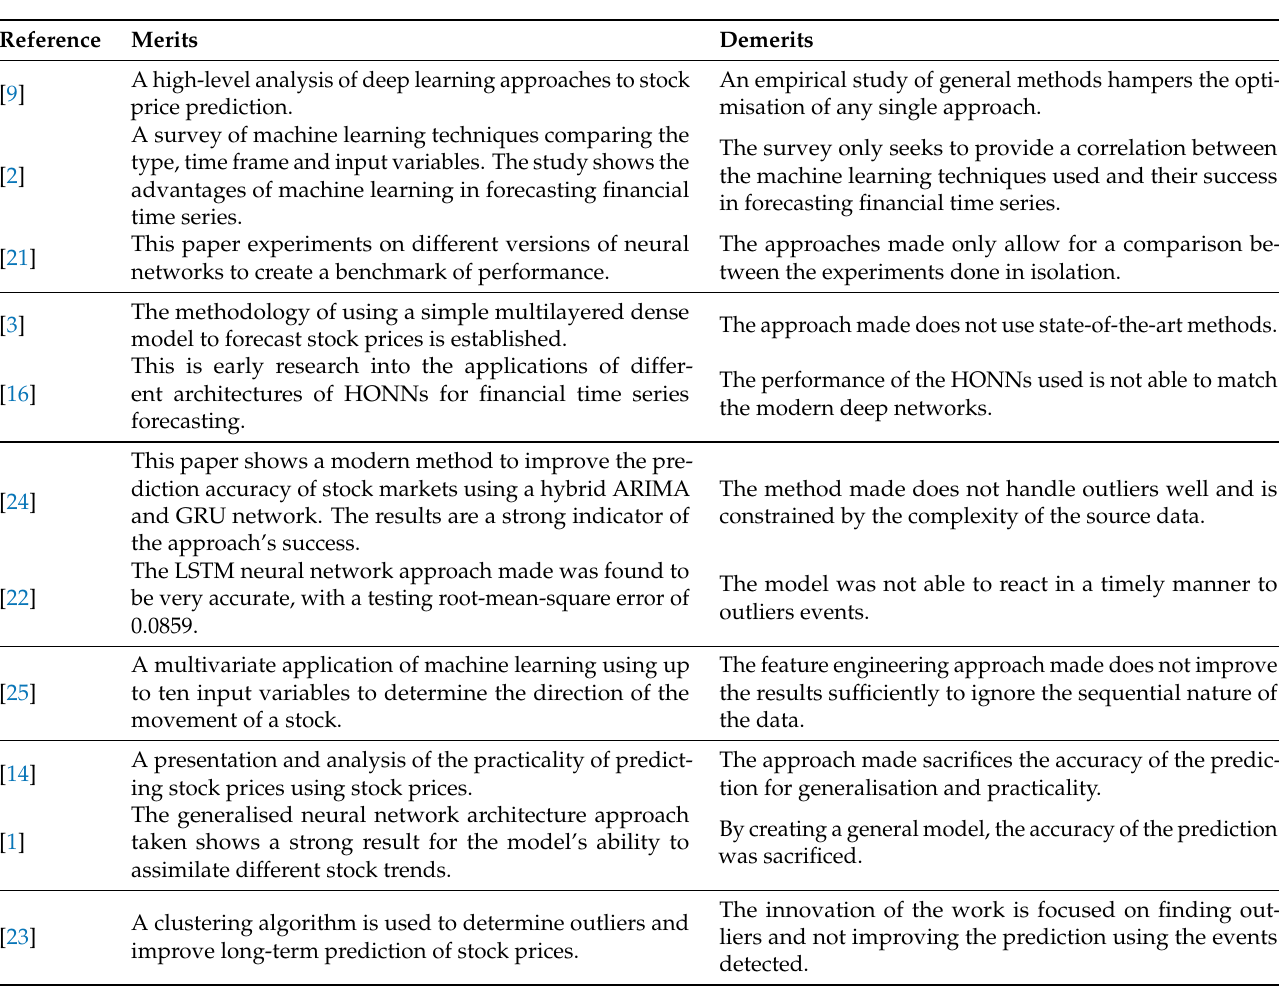
Table 1. Summary of related